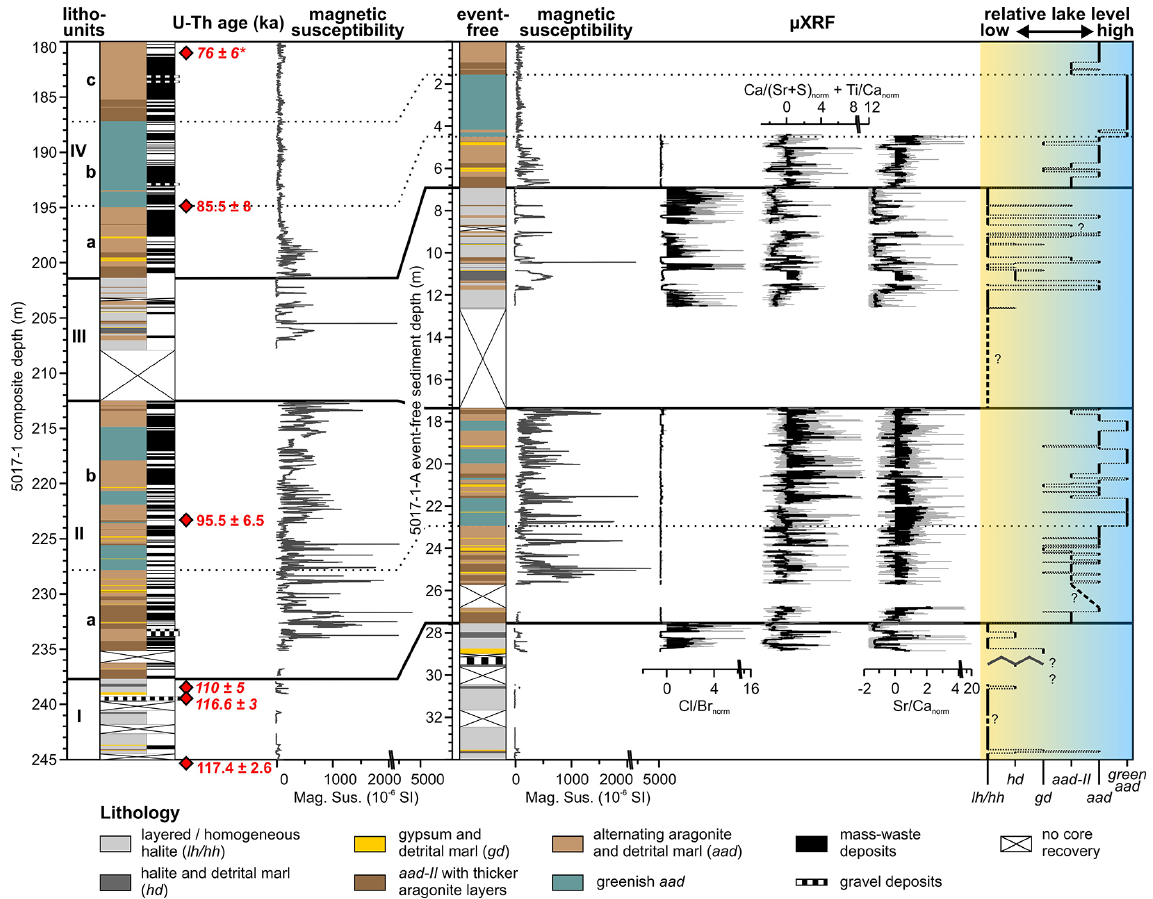
Figure 4. Lithology of the ∼ 65m long 5017-1 core section: lithostratigraphic units, U–Th ages (from Torfstein et al., 2015), with extrapo- lated ages in italic, ∗ – interpolated age (see text for explanation), magnetic susceptibility (1mm resolution, 10 − 6 SI); event-free lithology, µXRF data (grey: 200µm steps, black: 101-steps running means of counts) and the relative lake level changes inferred from the changing micro-facies. All mass-waste deposits thicker than 1cm were excluded from the event-free lithological profile and data; event-free sediment depth starts with zero at 180m below lake floor. µXRF data of normalised ratios: Cl / Br representing halite, Ca / (Sr + S) + Ti / Ca indicating the total carbonate and siliciclastic detritus, and Sr / Ca indicating